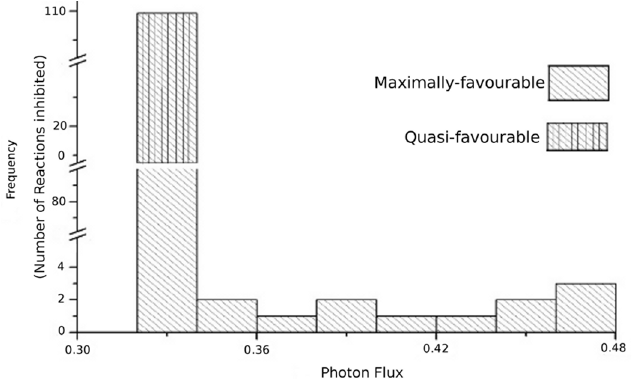
Fig 2. Histogram of minimum photon flux needed while deleting maximally and quasi-favourable reactions. Each reaction is deleted and photon demand for this perturbation is measured through FBA.